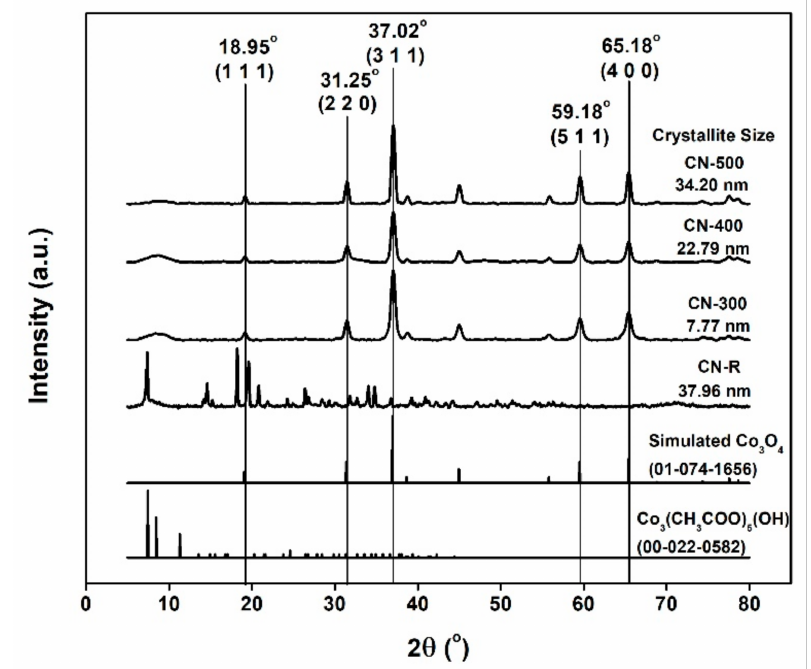
Figure 3. XRD spectra for CN − R, CN-300, CN-400, and